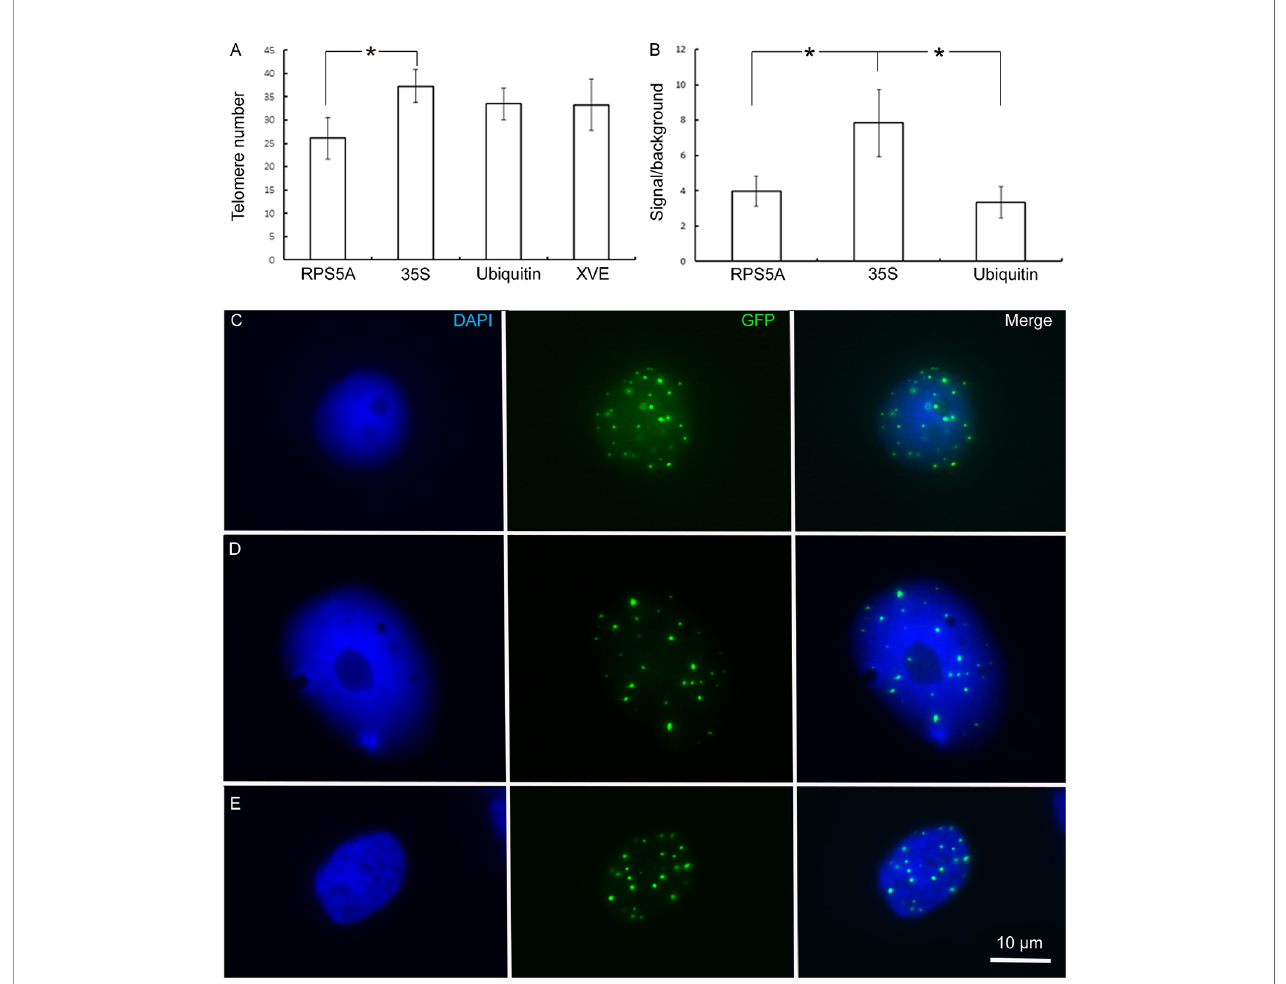
FIGURE 7 | Effect of different promotors used for expression of dCas9 on the ef fi ciency of telomere labeling. (A) The expression of dCas9 by PRS5A promoter resulted in the recognition of a smaller number of telomeres compared to 35S and ubiquitin promoters. The XVE inducible promoter was as ef fi cient as ubiquitin promoter regarding the number of labeled telomeres (p < 0.05). (B) 35S promoter caused the better signal to background noise ratio (p < 0.05). Data obtained from 10 isolated nuclei per construct. Regardless of promoter type, dCas9 driven by (C) RPS5A, (D) 35S, (E) XVE could label telomeric regions in N. benthamiana